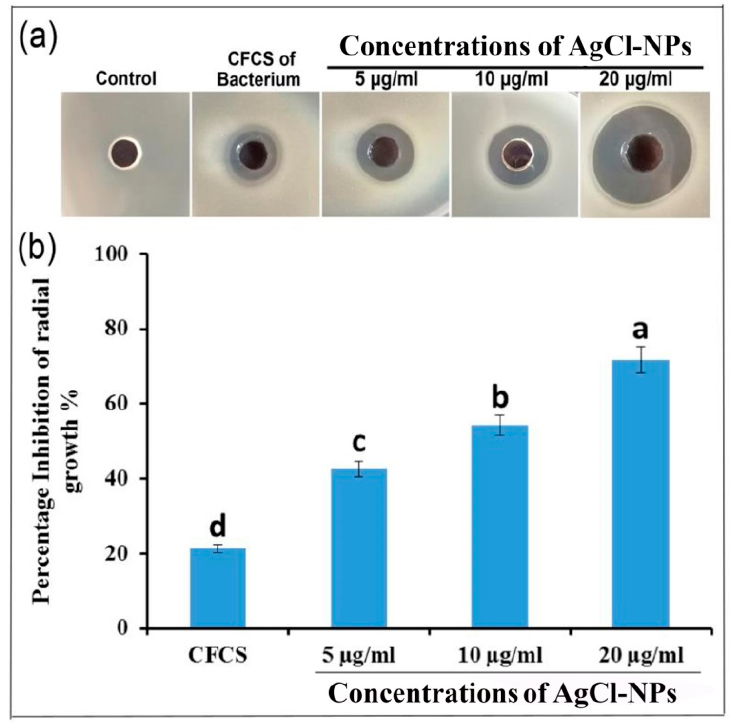
Figure 7. Antibacterial activity of the biosynthesized AgCl-NPs against phytopathogenic bacterium strain YY06: ( a ) inhibitory activity of different concentrations of AgCl-NPs against bacterial growth on LB agar; ( b ) percentage of bacterial growth inhibition of different concentrations of AgCl-NPs. Vertical bars represent standard errors of the means ( n = 3). The bars with different letters are significantly different ( p < 0.05). CFCS: cell-free culture